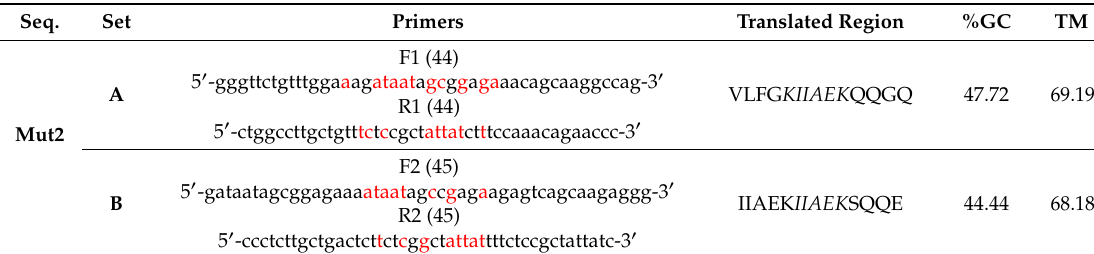
Table 3. Primers designed to introduce desired modifications on the Wt plasmid. Seq.